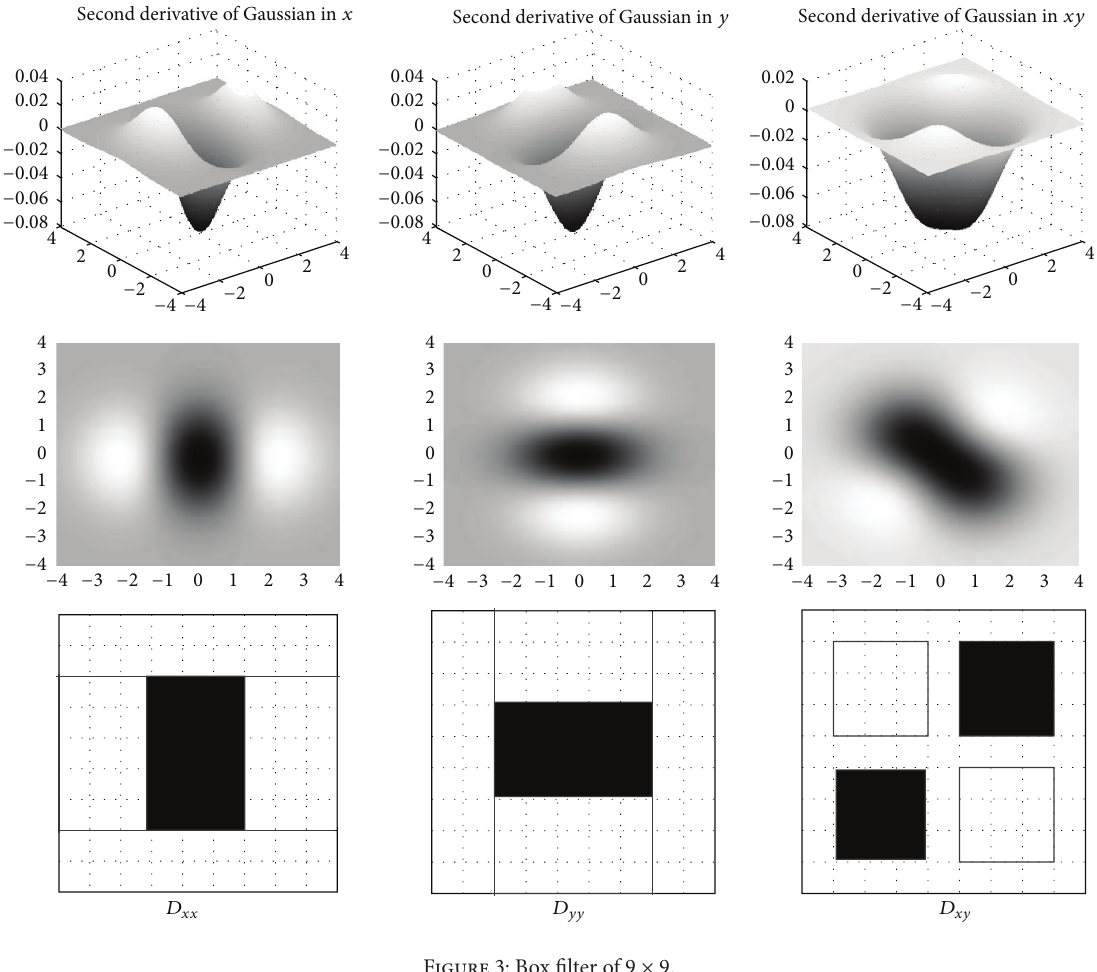
Figure 3: Box filter of 9 × 9